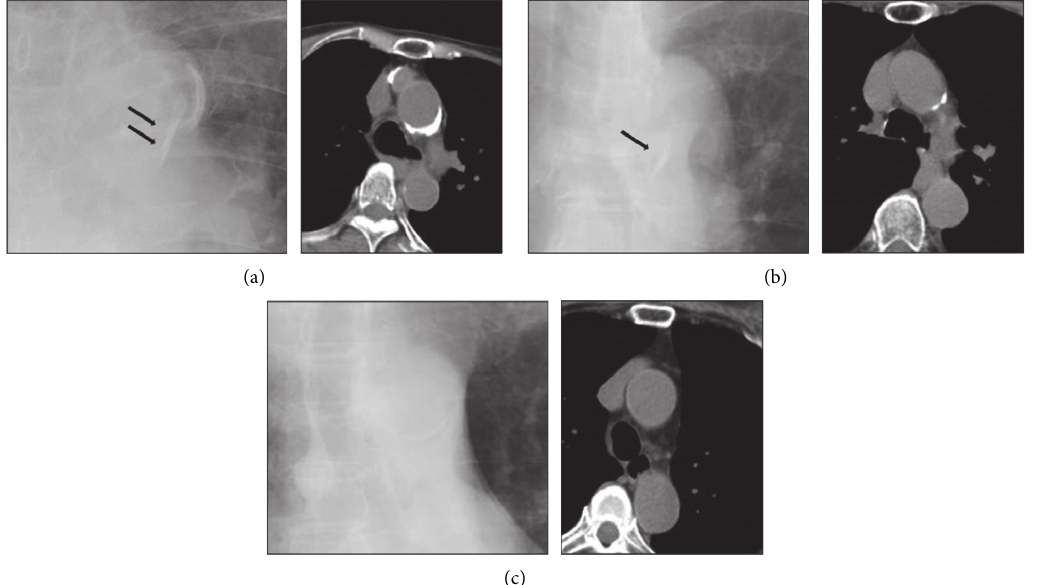
Figure 2: The classification of the Aortic Arch Tail Sign. The prominent calcification line confirmed by plain film and CT imaging was classified as +2. A line which was ambiguous with plain film imaging but was confirmed by CT was classified as +1. Images classified as 0 showed no calcification. (a) +2. (b) +1. (c) 0.